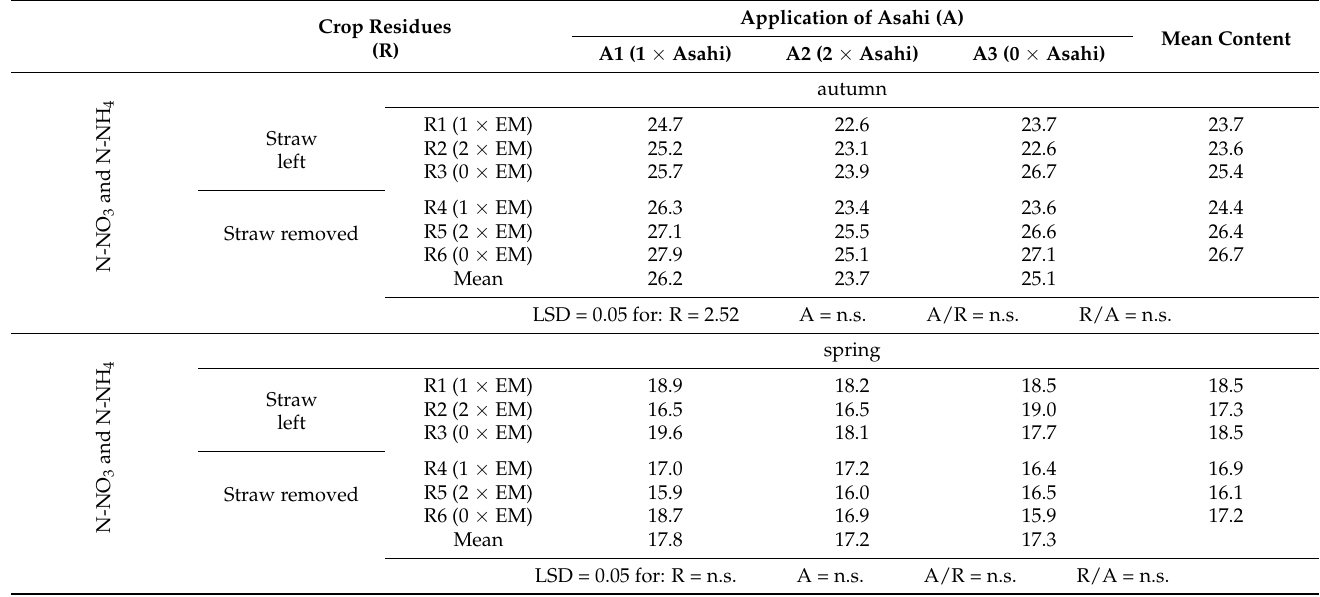
Table 4. Mineral forms nitrogen (N) content (mg · kg − 1 N-NO 3 N-NH 4 ) in the arable layer, depending on the management of plant residues with the addition of the biopreparation EM (R factor) and the application of the biostimulant Asahi (A factor) in spring barley